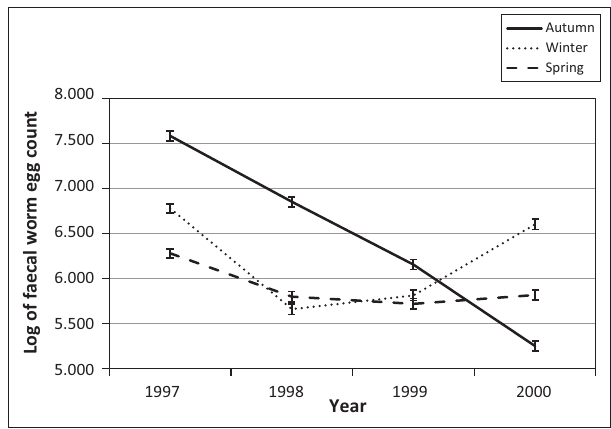
FIGURE 1: Interaction of year by season for the natural log of faecal worm egg count in the study population (log-transformed least-squares means ±